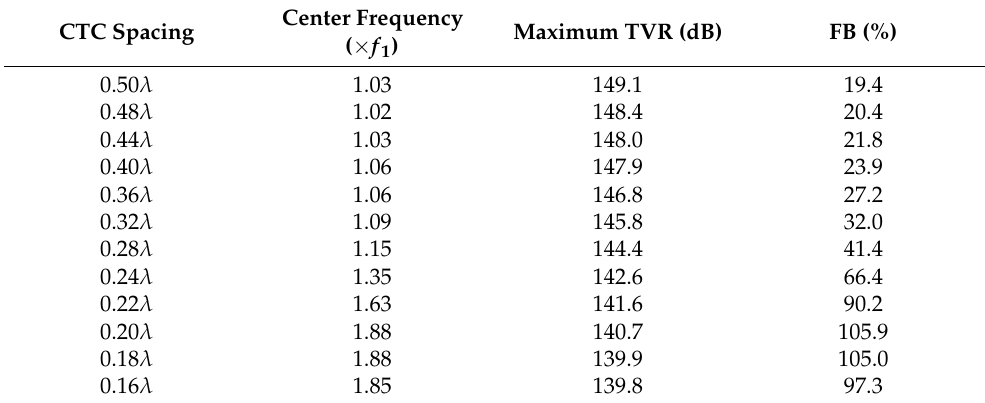
Table 3. Acoustic characteristics of the 3 × 3 two-layered cymbal array for various CTC spacings.